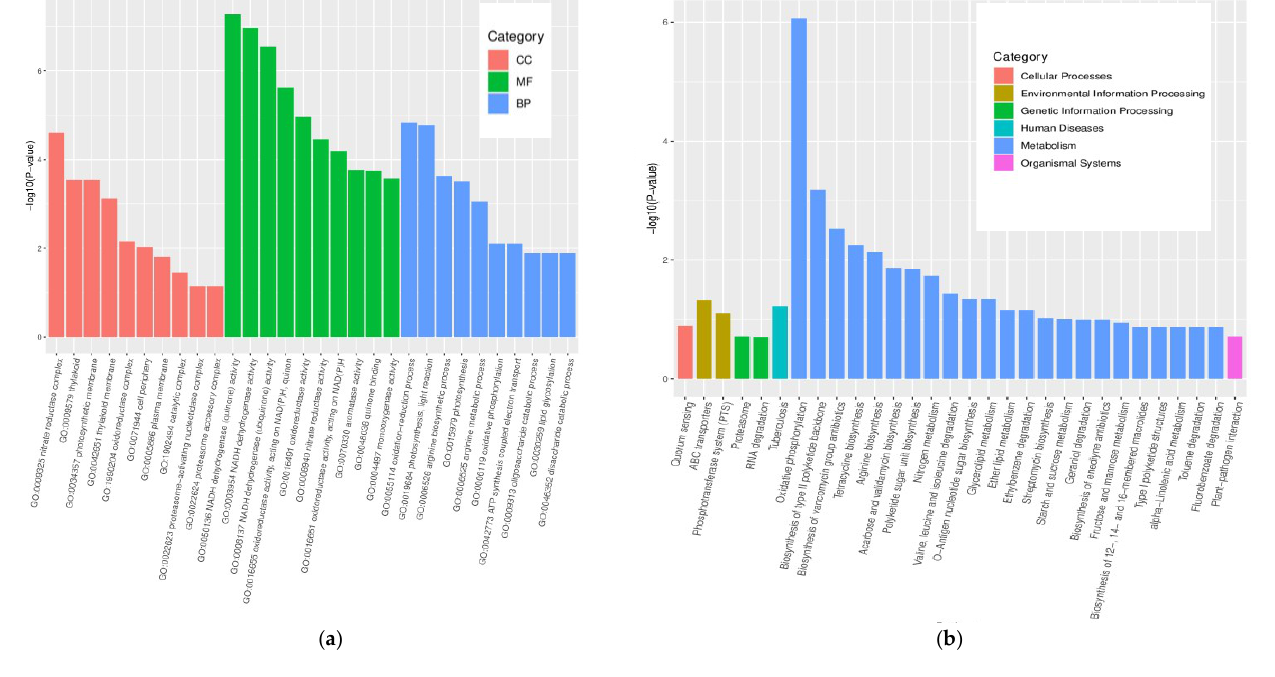
Figure 5. The DEGs of comparative transcriptomic analysis between strains 891 and 891-B6: ( a ) GO; ( b ) KEGG.